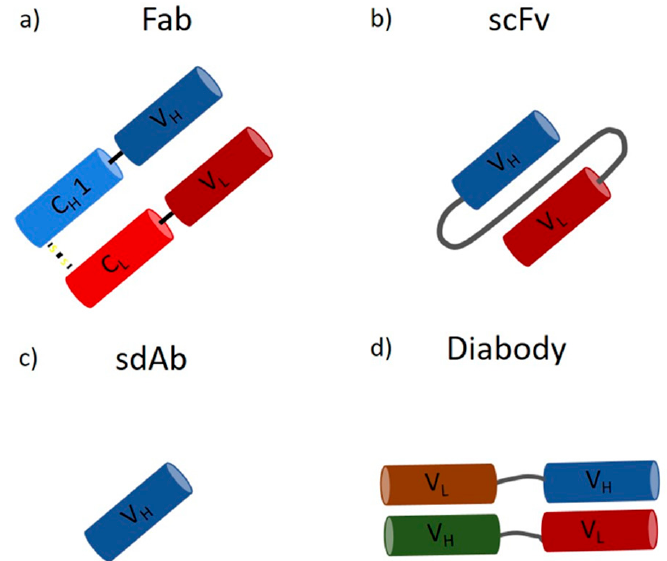
Figure 2. Antibody fragments: ( a ) the antigen-binding fragment (Fab) contains a variable and a constant domain of a light and heavy chain (size ~55 kDa); ( b ) the single-chain variable fragment (scFv) consists only of the variable domains, which form the antigen-binding part, linked together by a polypeptidlinker (size ~28 kDa); ( c ) the single-domain antibody (sdAb) consists of only one variable heavy chain (size ~15 kDa); ( d ) the diabody consists of two heavy and two light chains forming a bispecific fragment capable of binding two different antigens (size ~50 kDa).